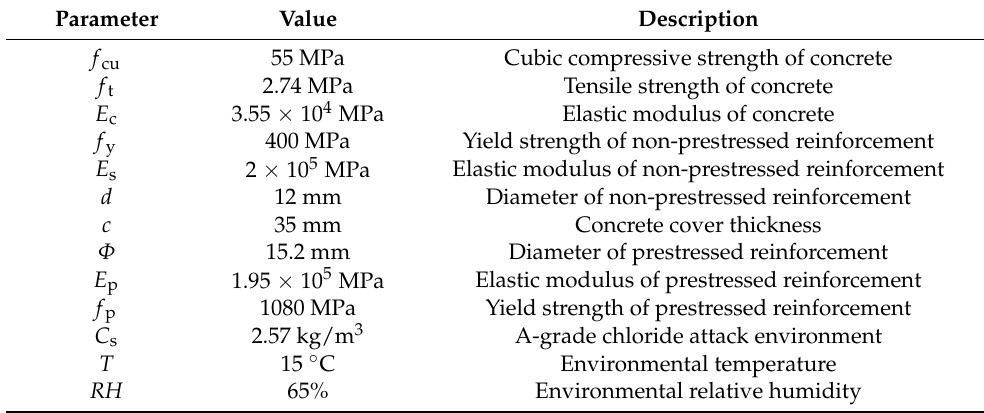
Table 4. Material parameter and environmental factor of the U-shaped beam.